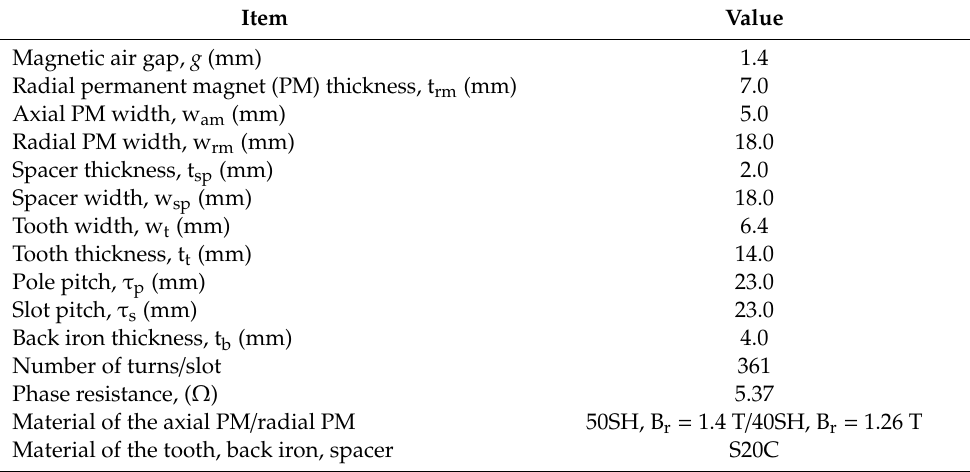
Table 1. Specifications of the single slot single pole